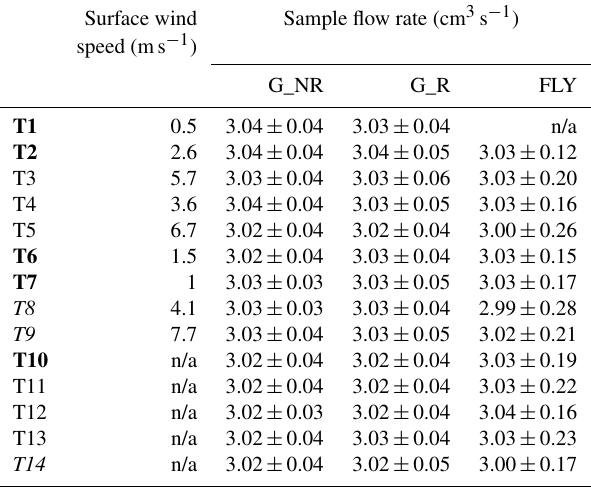
Table 4. Summary of the sample flow rates of each test flight at three stages. n/a = not applicable. The numbers denoted by ± x rep- resent the standard deviation in the sample flow rates during the measurement time